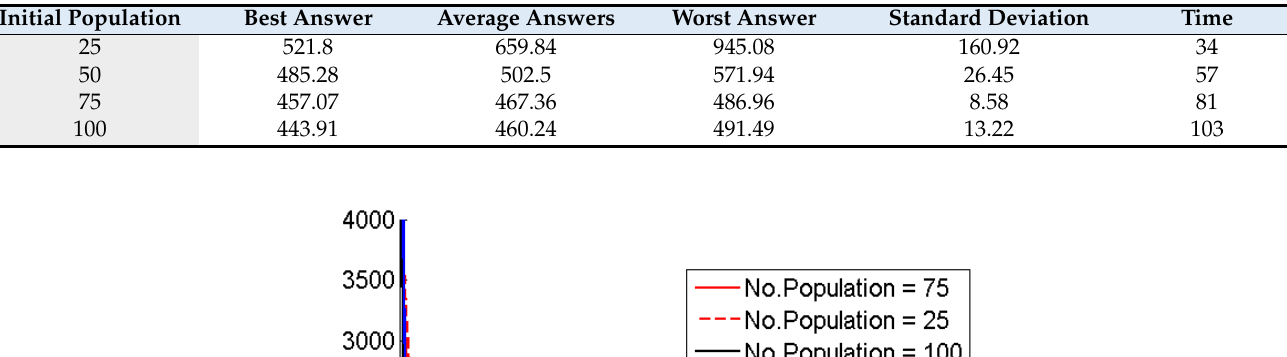
Table 21. The results of implementing the proposed algorithm with different initial populations for reducing pollution.